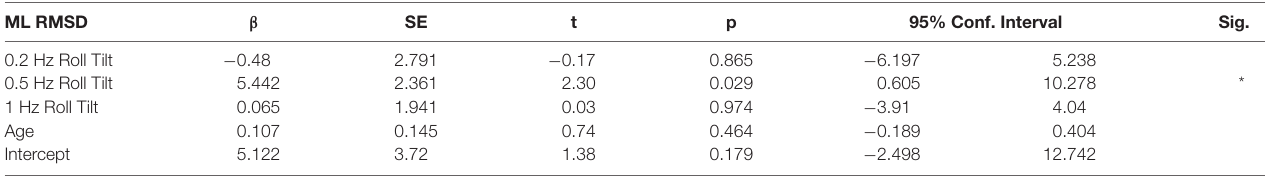
TABLE 2 | Results of a multivariable linear regression model.